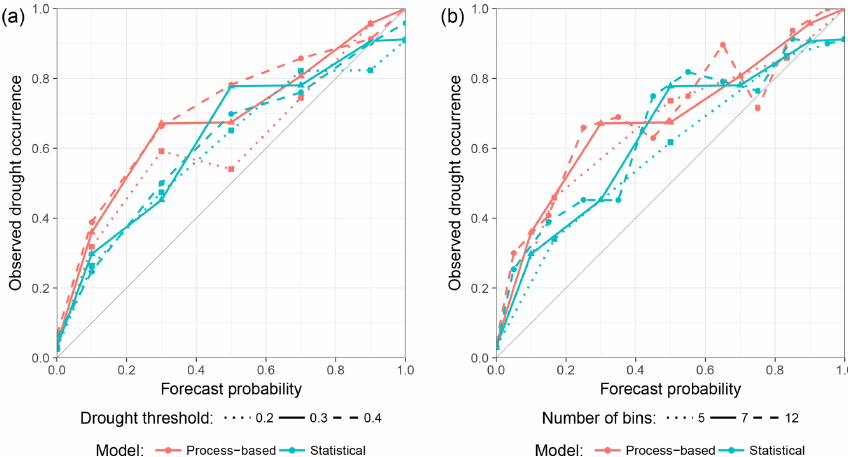
Figure 10. Reliability plots for different settings of (a) drought thresholds and (b) number of probability bins. Solid lines refer to the values used in this study. The gray 1 : 1 lines in each plot illustrate perfect reliability for